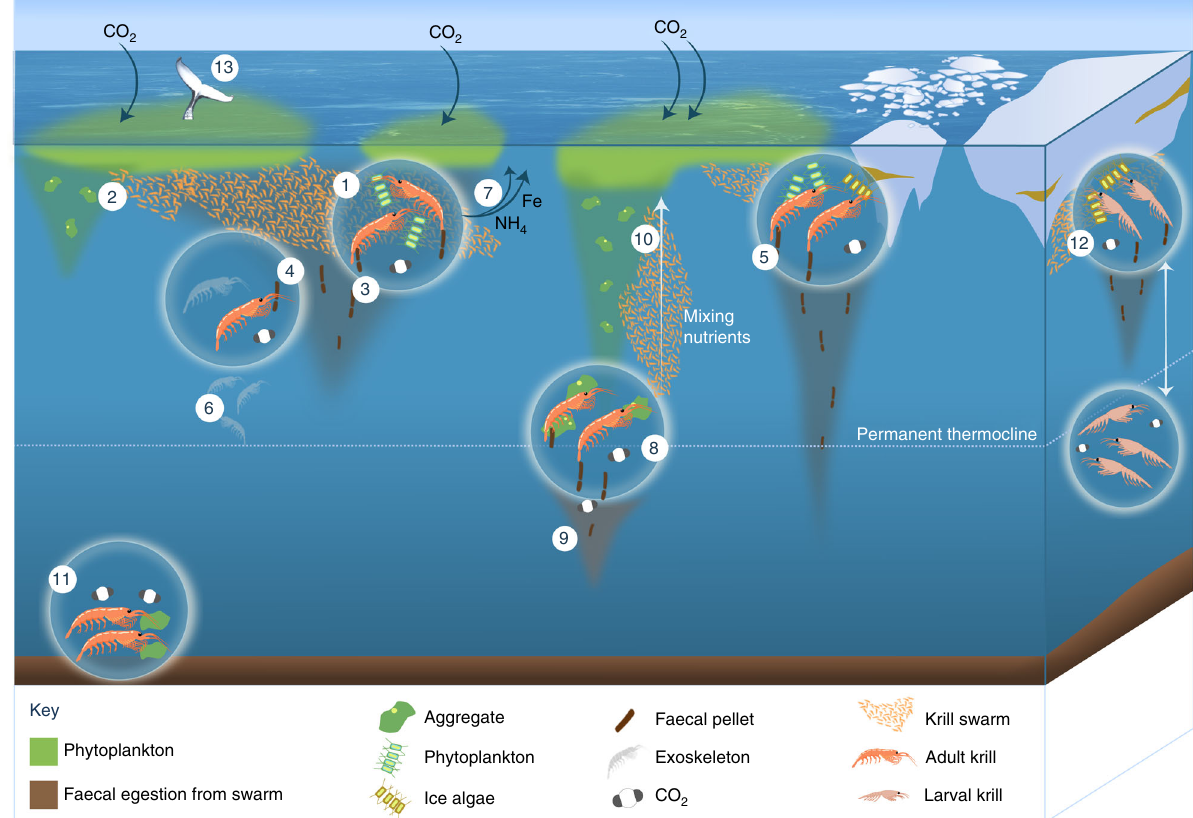
Fig. 3 Role of E. superba in biogeochemical cycles. Krill (as swarms and individuals) feed on phytoplankton at the surface (1) leaving only a proportion to sink as phytodetrital aggregates (2), which are broken up easily and may not sink below the permanent thermocline. Krill also release faecal pellets (3) whilst they feed, which can sink to the deep sea but can be consumed (coprophagy) and degraded as they descend (4) by krill, bacteria and zooplankton. In the marginal ice zone, faecal pellet fl ux can reach greater depths (5). Krill also release moults, which sink and contribute to the carbon fl ux (6). Nutrients are released by krill during sloppy feeding, excretion and egestion, such as iron and ammonium (7, see Fig. 2 for other nutrients released), and if they are released near the surface can stimulate phytoplankton production and further atmospheric CO 2 drawdown. Some adult krill permanently reside deeper in the water column, consuming organic material at depth (8). Any carbon (as organic matter or as CO 2 ) that sinks below the permanent thermocline is removed from subjection to seasonal mixing and will remain stored in the deep ocean for at least a year (9). The swimming motions of migrating adult krill that migrate can mix nutrient-rich water from the deep (10), further stimulating primary production. Other adult krill forage on the sea fl oor, releasing respired CO 2 at depth and may be consumed by demersal predators (11). Larval krill, which in the Southern Ocean reside under the sea ice, undergo extensive diurnal vertical migration (12), potentially transferring CO 2 below the permanent thermocline. Krill are consumed by many predators including baleen whales (13), leading to storage of some of the krill carbon as biomass for decades before the whale dies, sinks to the sea fl oor and is consumed